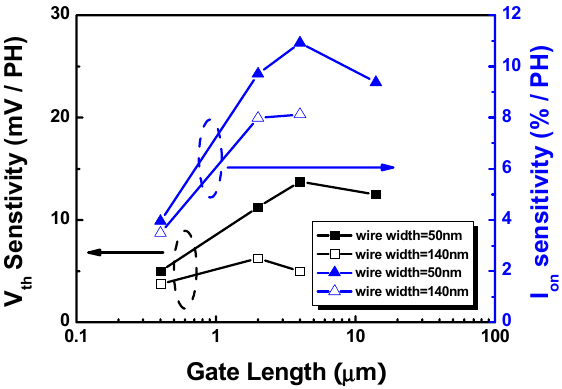
Figure 6. ( a ) Schematic representations of the nanowire surface after functionalized treatment steps. After the series process, oligo DNA can be bound effectively on the nanowire surface to react with the subsequent primer DNA; ( b ) The V nanowire FETs at various DNA concentrations. Approximately 100 mV of the V still present as the primer DNA concentration is lowered to 10